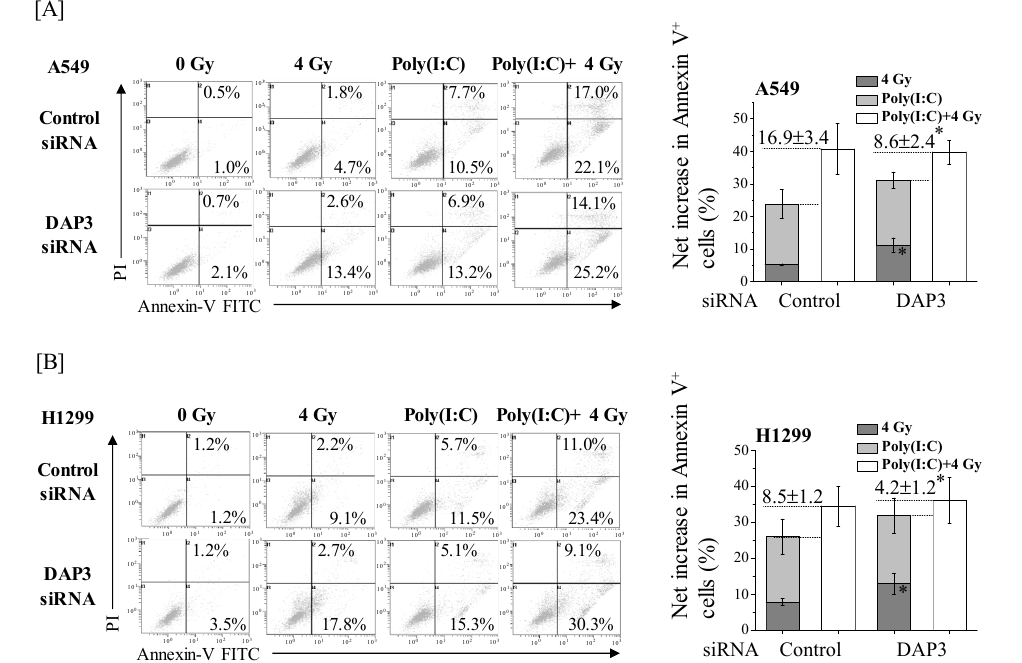
Figure 5. DAP3 is involved in the more-than-additive effect of cotreatment with Poly(I:C) and IR on induction of cell death. DAP3-knockdown A549 ( A ) and H1299 cells ( B ) were incubated with Poly(I:C). After incubation for 1 h, the cells were irradiated with 4 Gy. After culturing for 72 h, the cells were harvested for cell death assay using annexin V/PI staining. ( left ) Representative cytograms of annexin V/PI staining are shown. The inset numbers indicate the fractions of annexin V+/PI − or annexin V+/PI+ cells. ( right ) The results are presented as the net increase in the fraction of annexin V+ cells (the sum of annexin V+/PI − cells and annexin V+/PI+ cells). Data are presented as mean ± SD of three independent experiments. * p < 0.05 versus control siRNA.